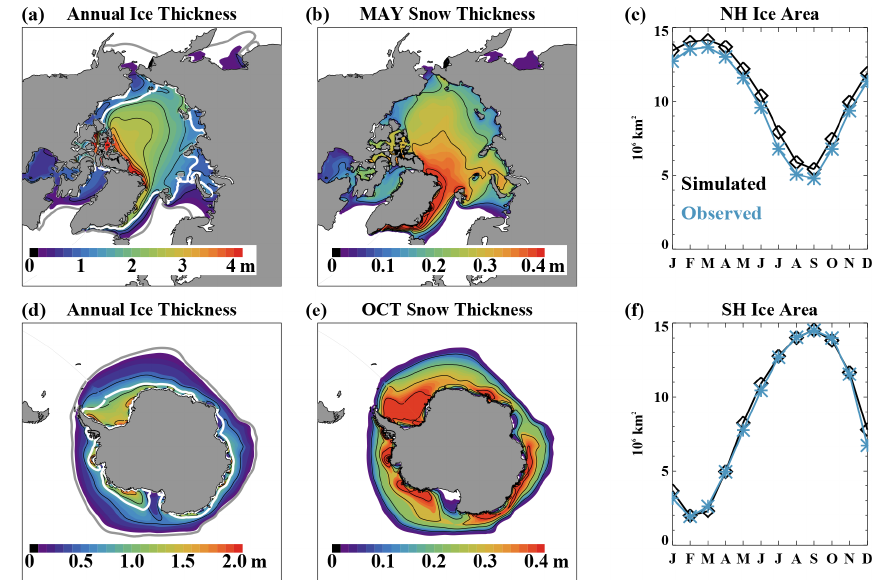
Figure 1. The simulated Northern Hemisphere (a) annual ice thickness, (b) May snow depth, and (c) ice area as well as Southern Hemisphere (d) annual ice thickness, (e) October snow depth, and (f) ice area. On the ice thickness plots, the contour interval for the black lines is 0.5m, and the simulated 15% ice concentration for March and September is shown in the bold white and gray contour lines. For the snow thickness plots, the contour interval for the black lines is 0.1m. The observed ice area averaged from 1979–2013 shown on panels (c) and (f) is from the NSIDC sea ice index (Fetterer et al.,